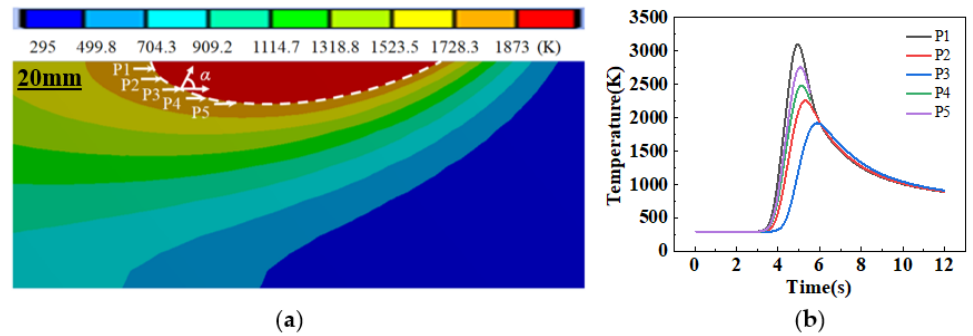
Figure 8. Temperature curves of molten pool at different positions over time. ( a ) Molten pool temperature distribution, ( b ) Variation trend of temperature in different positions of molten pool.